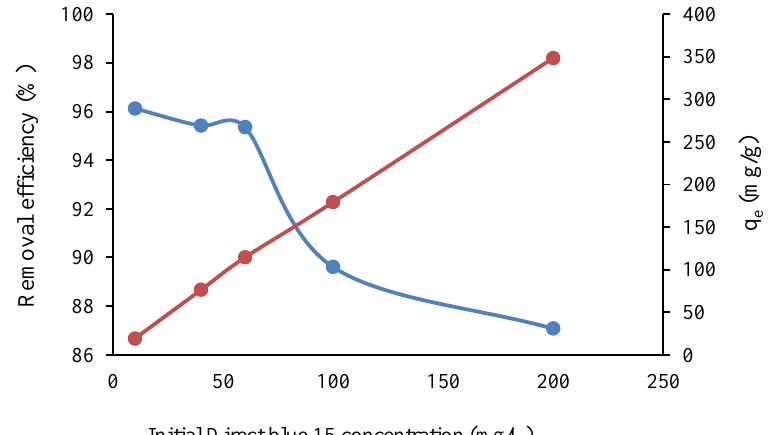
Fig. 8. Effect of initial dye concentration on removal efficiency using EDTA and chitosan-modified MWCNT (pH: 7, contact time: 60